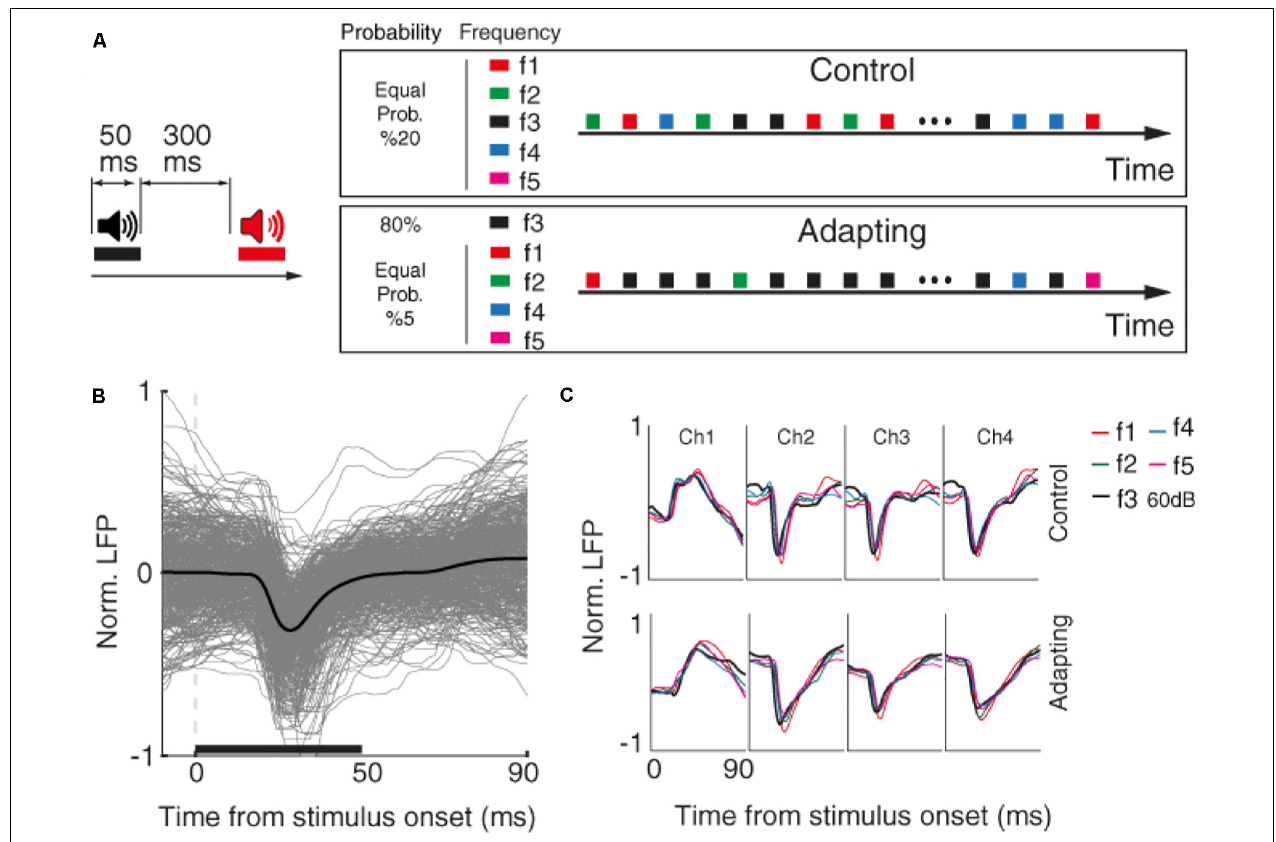
FIGURE 1 | Behavioral task and raw data. (A) Timeline of the stimulus presentation in two control and adapting sequences. Left: pure tone stimuli with the duration of 50 and 300 ms inter-stimulus interval were presented. Right: stimuli were presented in two adapting and control sequences. Within the control sequence, stimuli were presented with an identical probability. Within the adapting sequence, the same combinations as the control sequence were presented such that the adapter and rest frequencies were presented with the likelihood of 80 and 20% of the whole sequence, respectively. (B) Raw LFP for a sample recording site. The x -axis shows the time from stimulus onset, and the y -axis is normalized LFP amplitude. Gray lines show LFP trace of different trials and black line denotes the average response. The horizontal bar shows the stimulus period. (C) Average raw LFPs of five frequencies of pure tones at 60 dB SPL level for a sample recording site (site 14) during the time following stimulus onset, in control (top panel), and adapting (bottom panel)